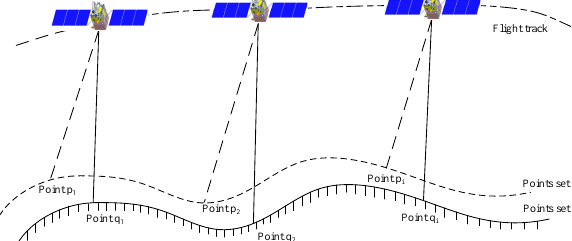
Figure 1. Satellite laser altimeter geometric calibration based on terrain matching